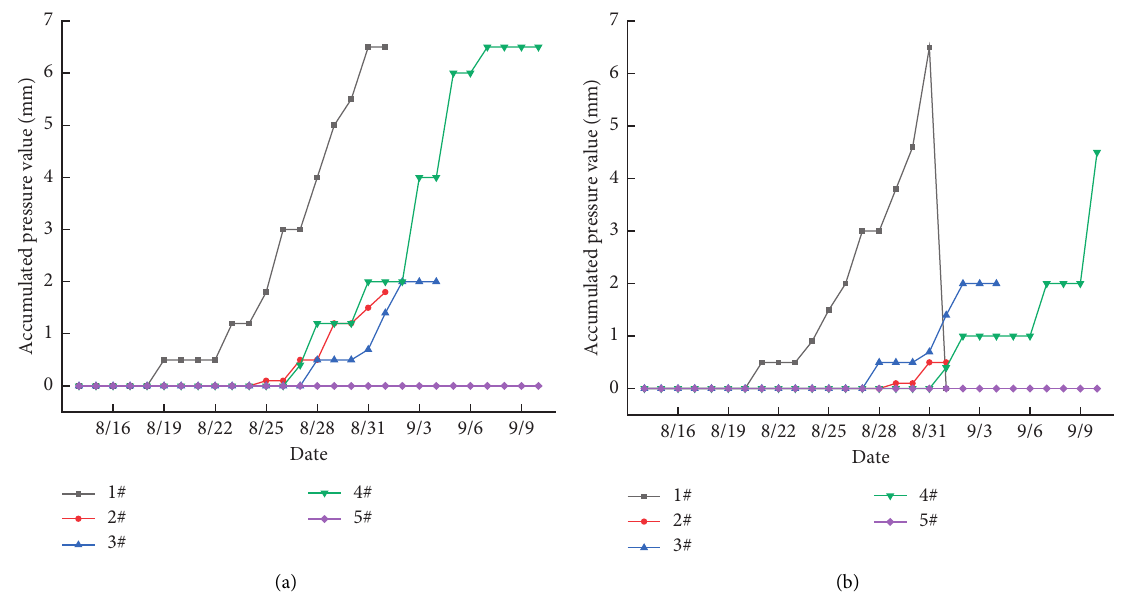
Figure 11: Monitoring data of shallow basis points. (a) Single hydraulic prop support. (b) Anchor cable support.